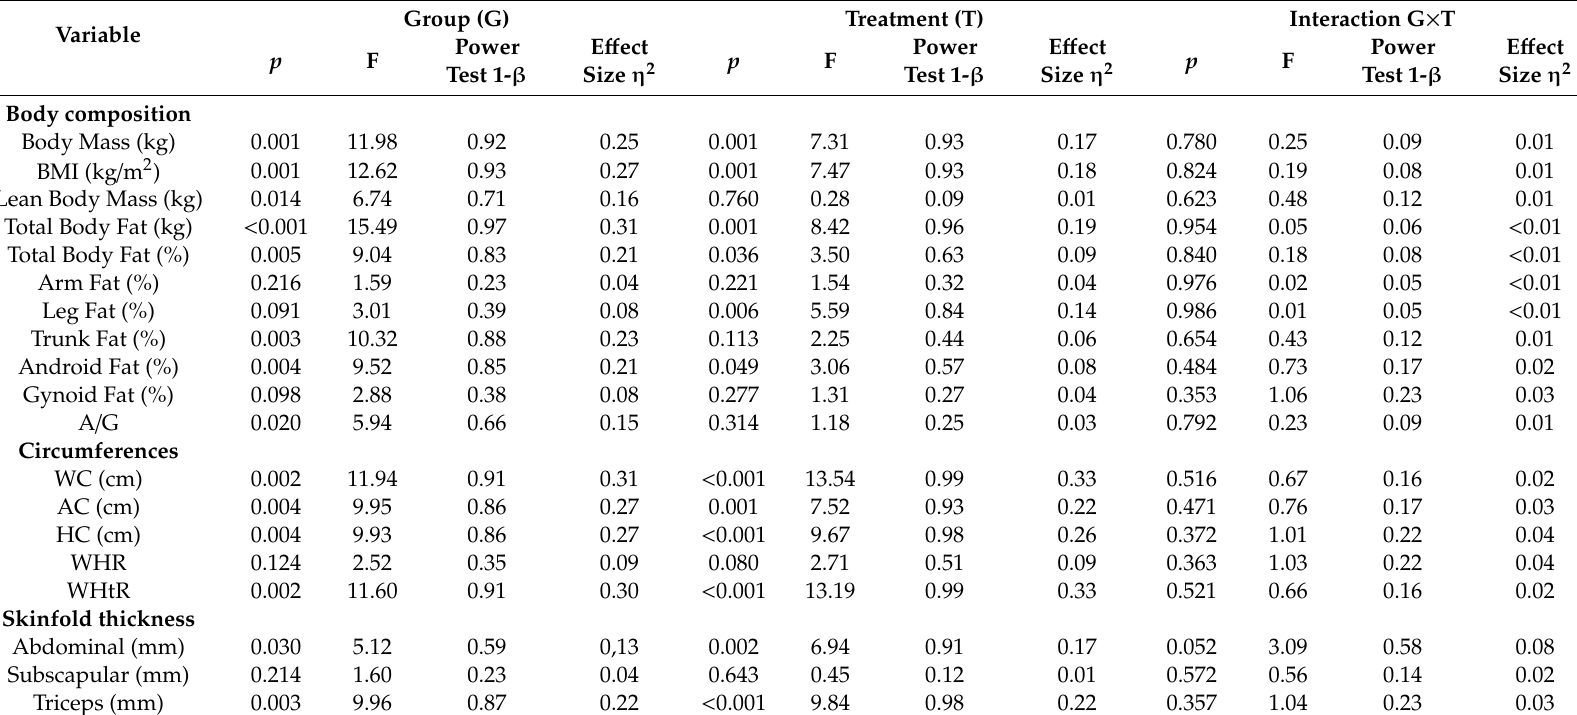
Table 3. Assessment regarding the e ff ects of whole-body cryotherapy (WBC) treatments on changes in body composition markers-analysis of variance with repeated measures